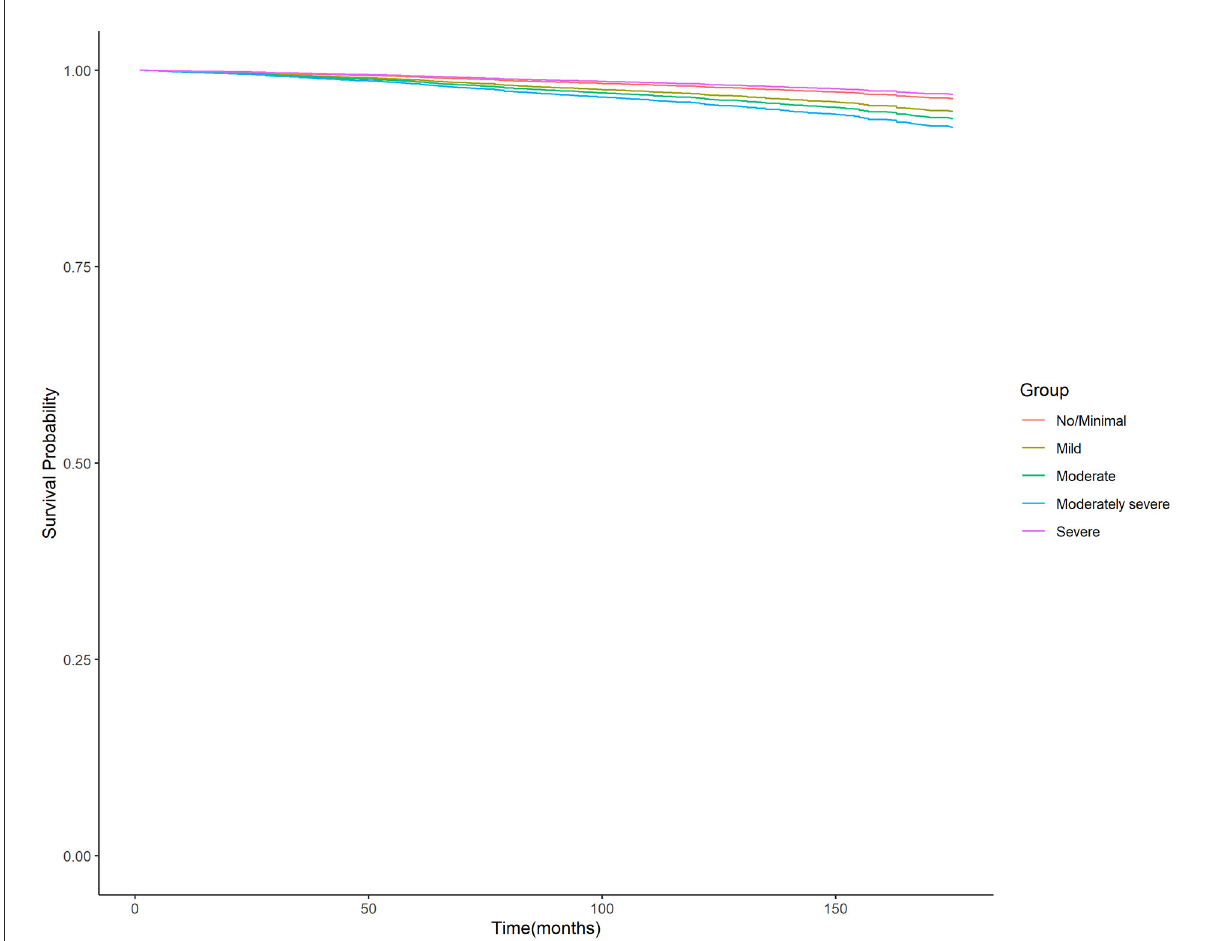
FIGURE4 Unadjusted survival curves of weighted cox proportional hazard model for cardiovascular mortality. PHQ-9, nine-item Patient Health Questionnaire.